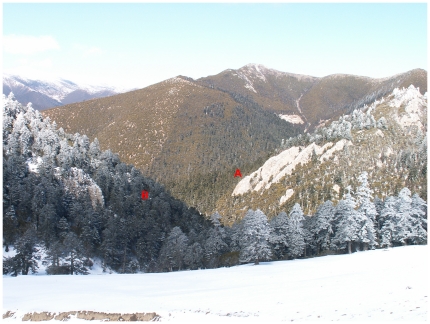
Two neighboring ranges (A and B) with different amounts of solar radiation on the second day after snow.A: there was almost no snow covering the tree canopy in a range with an average solar radiation about 241 KWH/m2 (MAP 2, see Table 1); this is one of the preferred habitats immediately after snow (see Fig. 3). B: a snow layer of about 5–7 cm covered most of the tree canopy in a range with solar radiation of 180 KWH/m2 (MAP 5); the canopies were usually not available for foraging for about 3 to 4 days after snow.